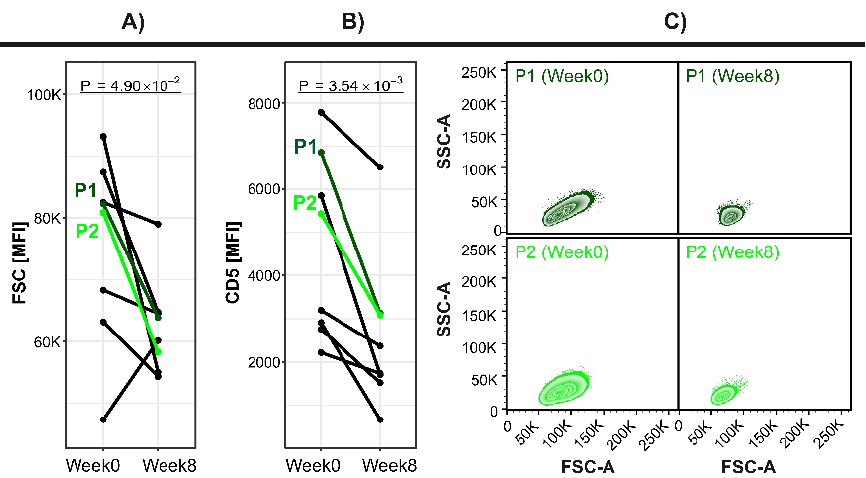
Figure 9. The impact of ibrutinib (IBR) treatment on CLL cell size and phenotype. The patients ( n = 8) were sampled before the initiation of IBR therapy and after 8 weeks of IBR therapy. ( A ) The distribution of CLL cell sizes (expressed as FSC), ( B ) CD5 expression in individual patients and ( C ) the SSC/FSC dot plots in two representative CLL patients (P1, P2) before and after 8 weeks of IBR treatment.